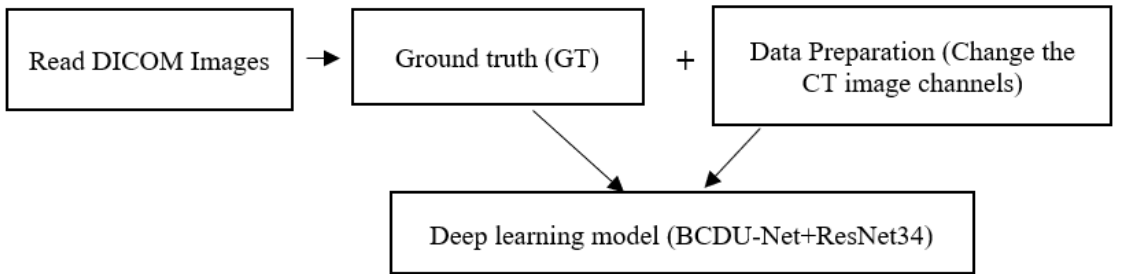
Figure 3. The pipeline of the proposed method.